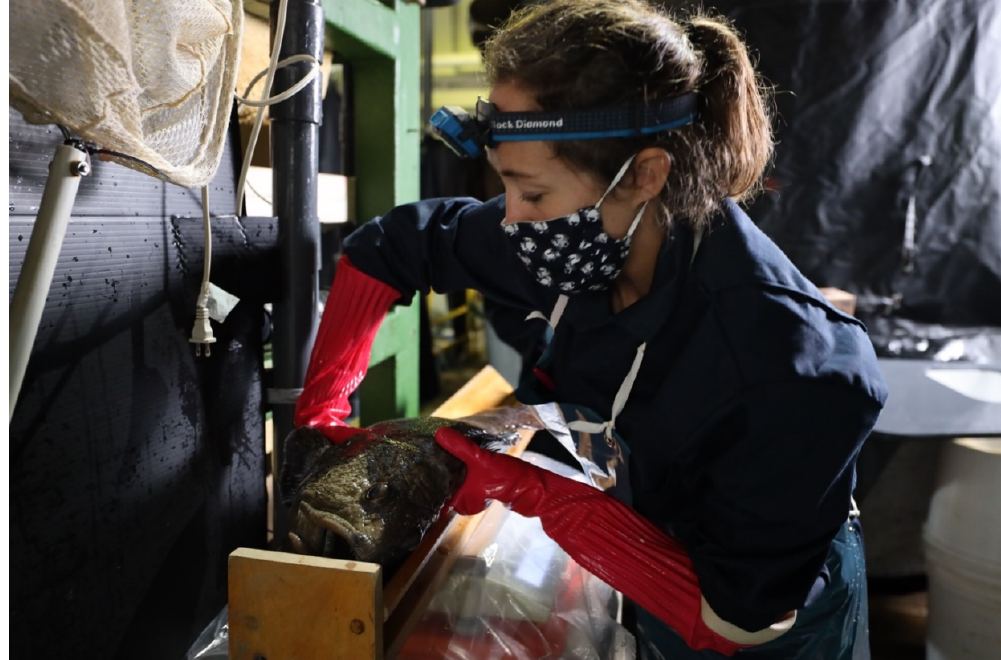
Figure 6. Handling of broodstock fish at Merinov facilities (Grande-Rivière, QC, Canada). Source: MERINOV, Dupont-Cyr, B.-A.